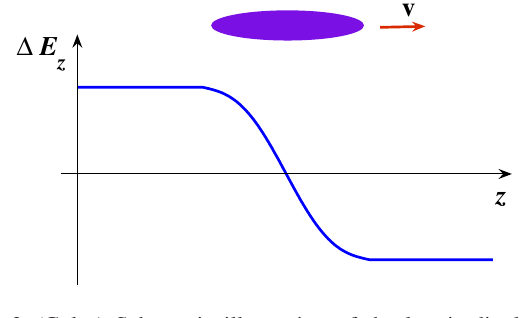
FIG. 2. (Color) Schematic illustration of the longitudinal field term